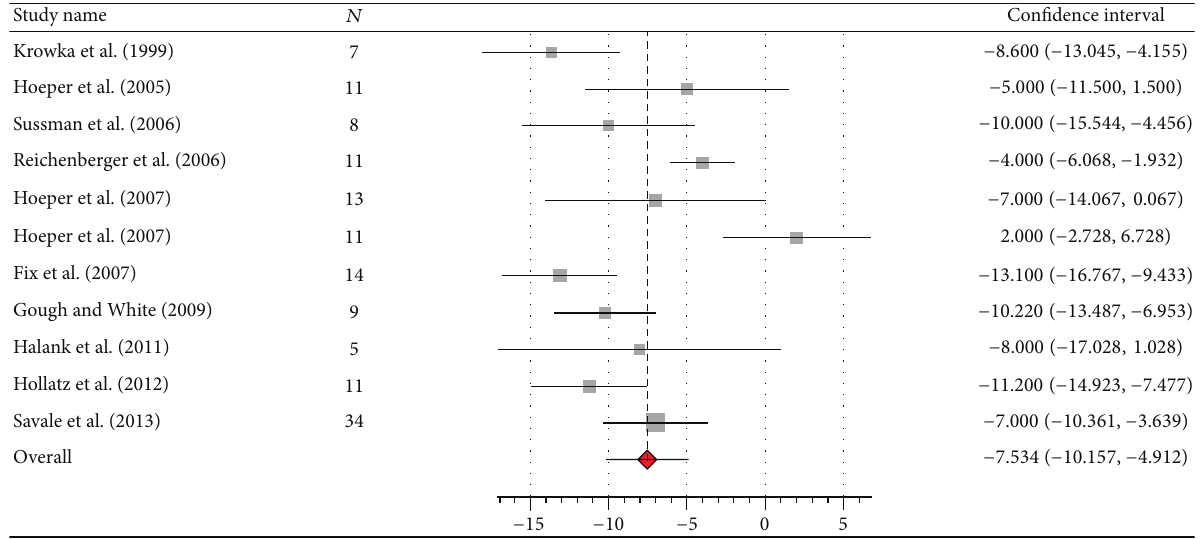
Figure 2: Effect of pulmonary arterial hypertension specific therapy on mean pulmonary artery pressure (mmHg). Forest plot: 95% confidence interval